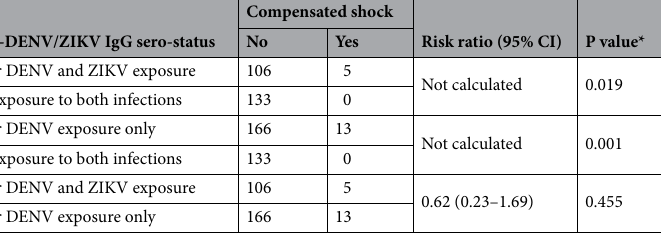
Table 4. Association between previous DENV/ZIKV exposure and compensated shock during the current DENV infection. *Calculated as two-tailed p value with Fisher’s exact test.